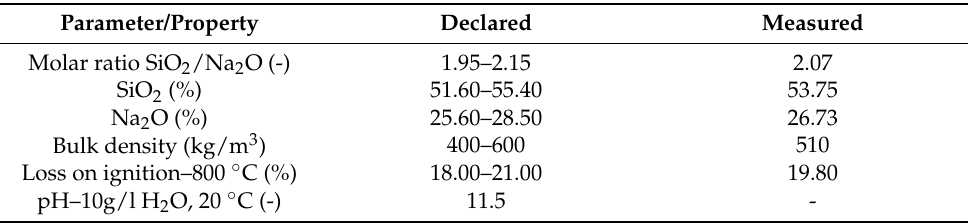
Table 2. WG characterization (values declared by supplier Vodní sklo a.s.).